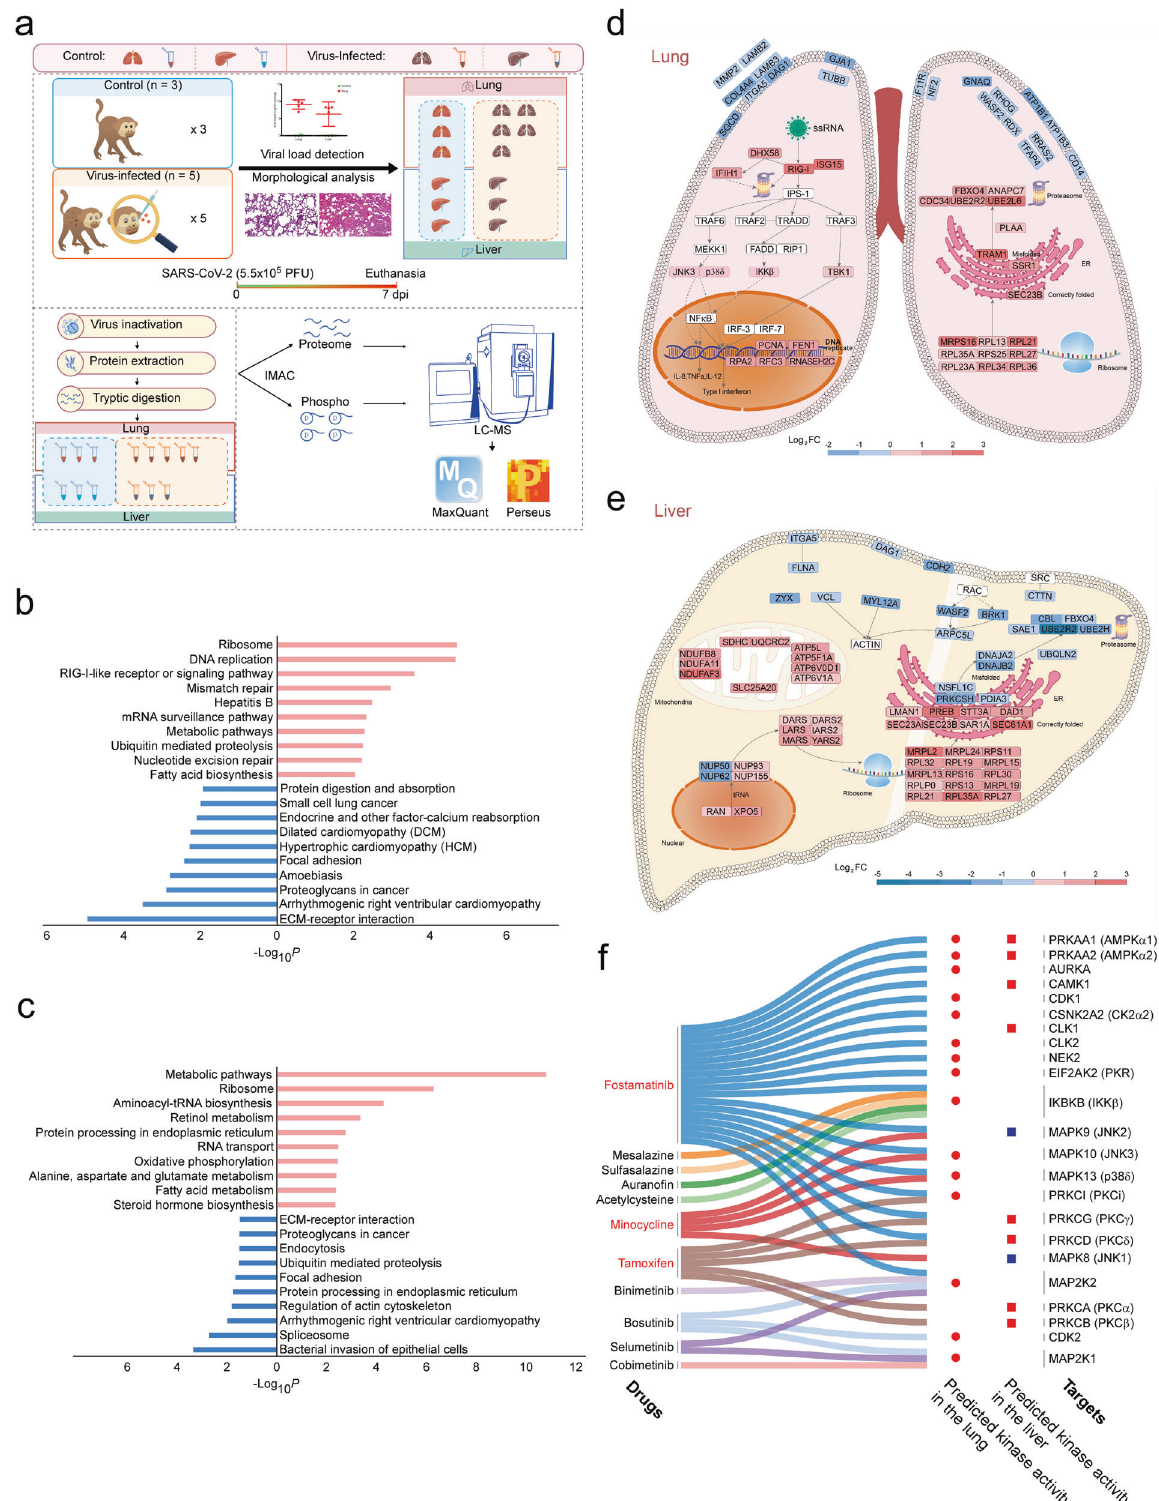
the downregulated proteins, the lung contained more ECM (COL4A4, LAMB2, LAMB3, and MMP2) and cellular membrane ones (GJA1, ATP1B1, and ATP1B3; Fig. 1d) while the liver contained more actin-regulated ones (MYL12A, WASF2, BRK1, and ARPC5L; Fig.